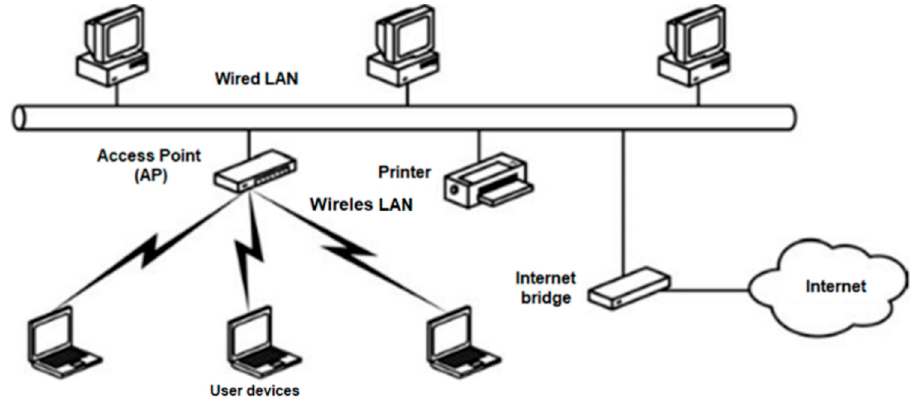
Figure 5. LAN network.